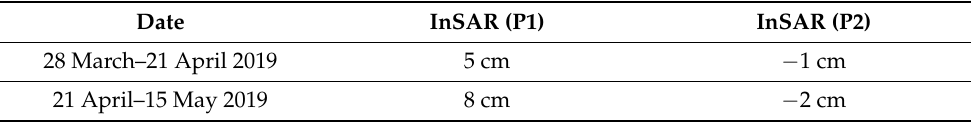
Table 4. D-InSAR measurements at location P1 and P2 using ascending Radarsat-2 FQ13.